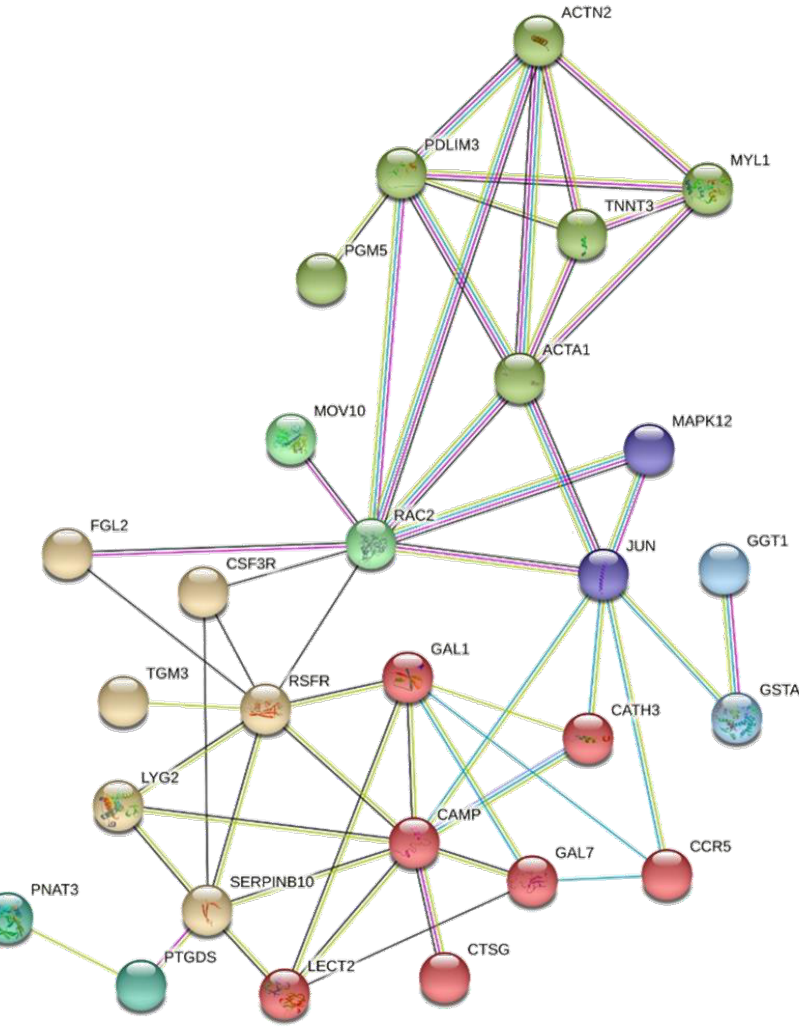
Figure 3. Gene network of unique DE genes in the articular cartilage from normal and FHS-affected broilers using STRING. Colored circles represent genes with similar functions or acting in similar pathways, and lines represent the predicted interactions between genes.